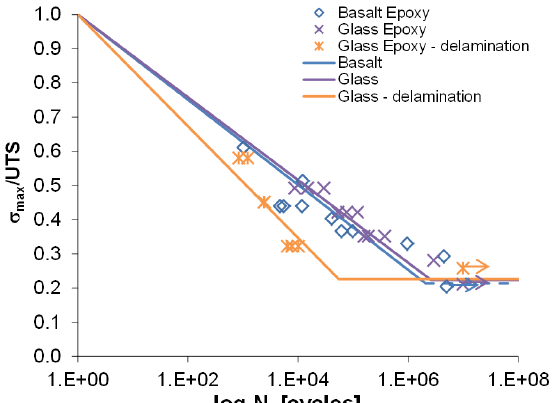
Figure 7: Normalized fatigue curves for all the materials. A linear interpolation is added in the finite life region, and the fatigue limit is plotted in the infite life region.